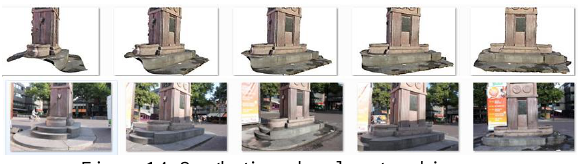
Figure 14. Synthetic and real captured images.